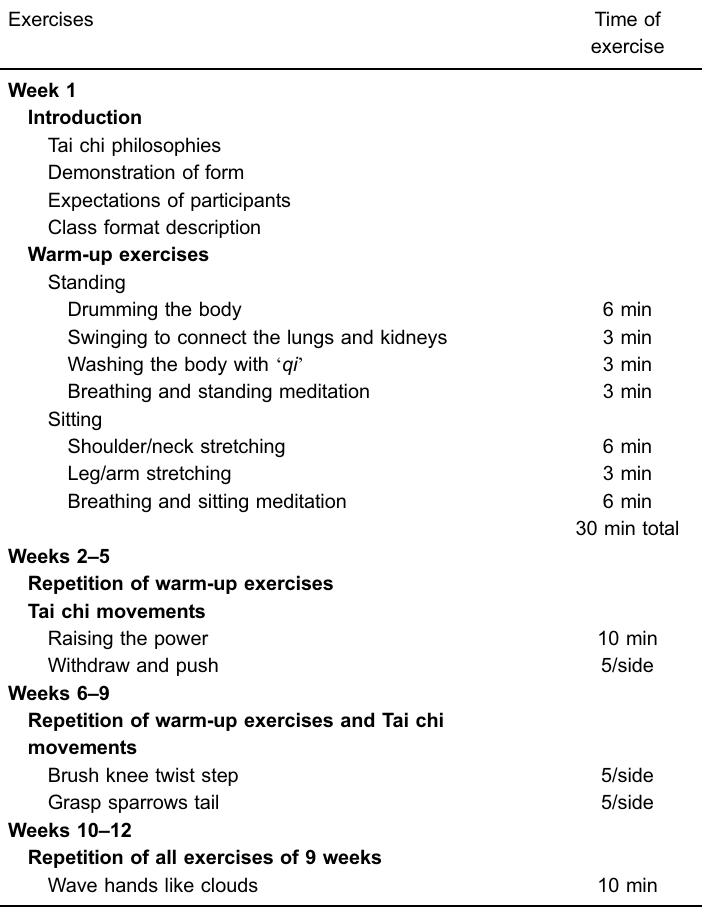
Table 1. Tai chi exercise